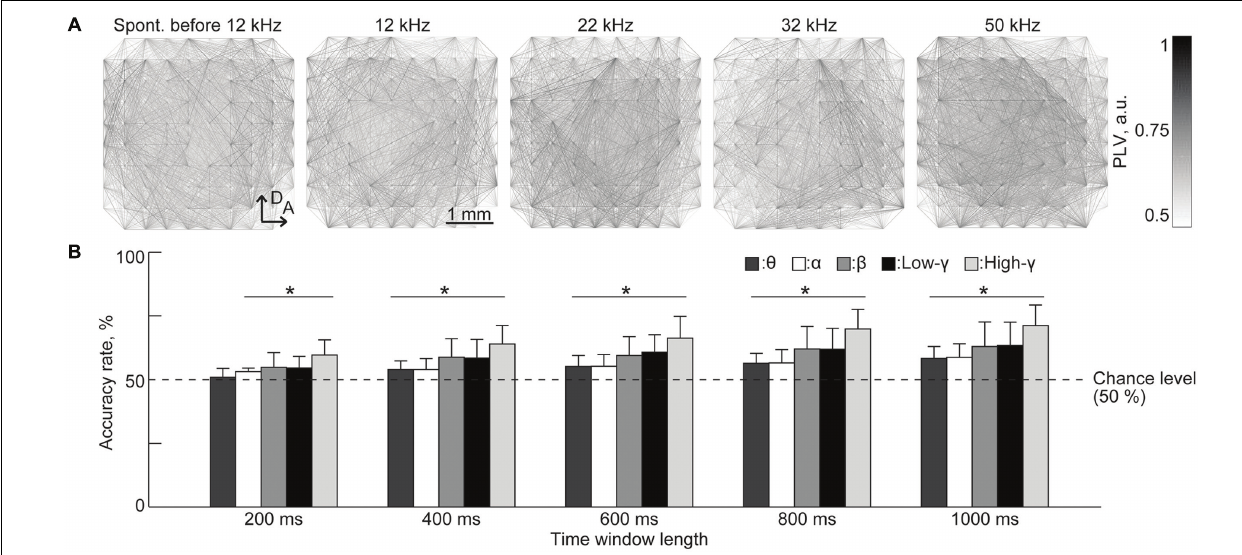
FIGURE 6 | Sparse logistic regression decoding from the PLVs of sustained activities. (A) Representative spatial pattern of high-gamma PLV for 1,000 ms in spontaneous activity (leftmost) and in response to varied test frequencies: 12, 22, 32, and 50 kHz. (B) Decoding accuracy. Bands and the duration of the time window served as parameters. Asterisks indicate that the decoding performance was better than the chance level, i.e., 50%: ∗ p < 0.05 (Wilcoxon signed-rank test). Spont., spontaneous activity.